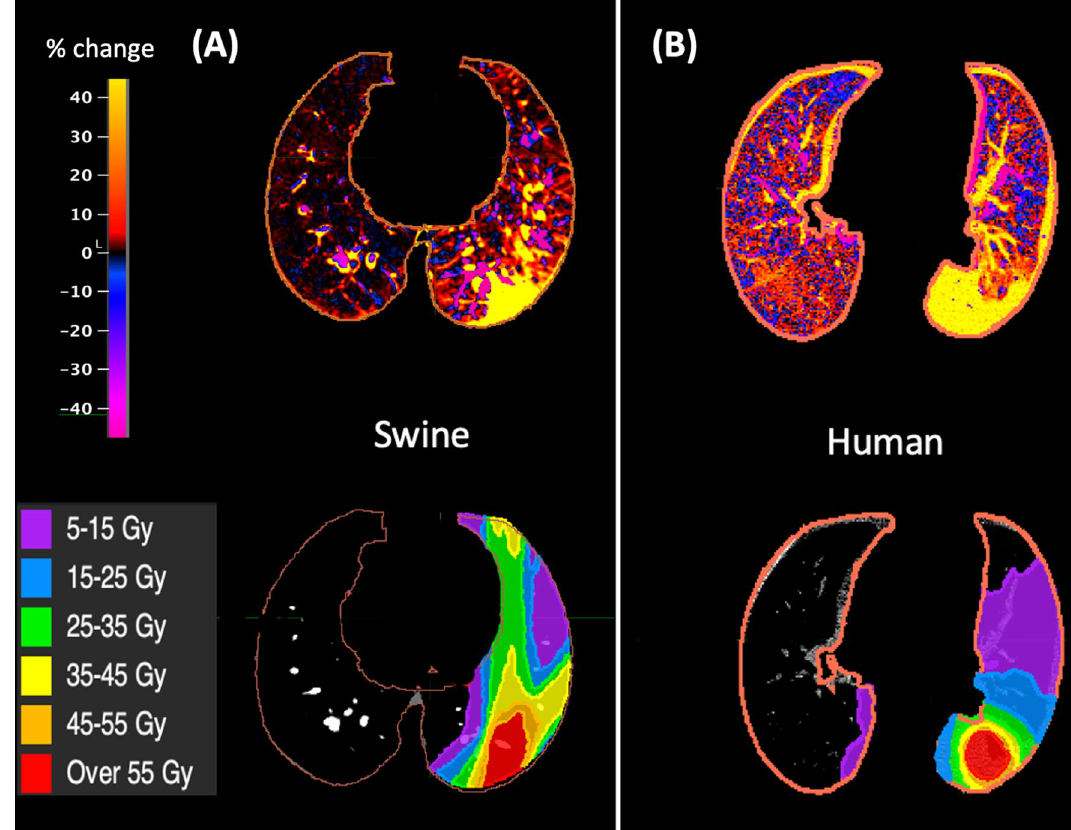
Figure 4. ( A ) Heat map showing the percent change in HU in each voxel with the corresponding dose distribution for a typical WMS swine ( B ) for an SBRT treated human. In all cases, large increases in HU are localized to areas receiving